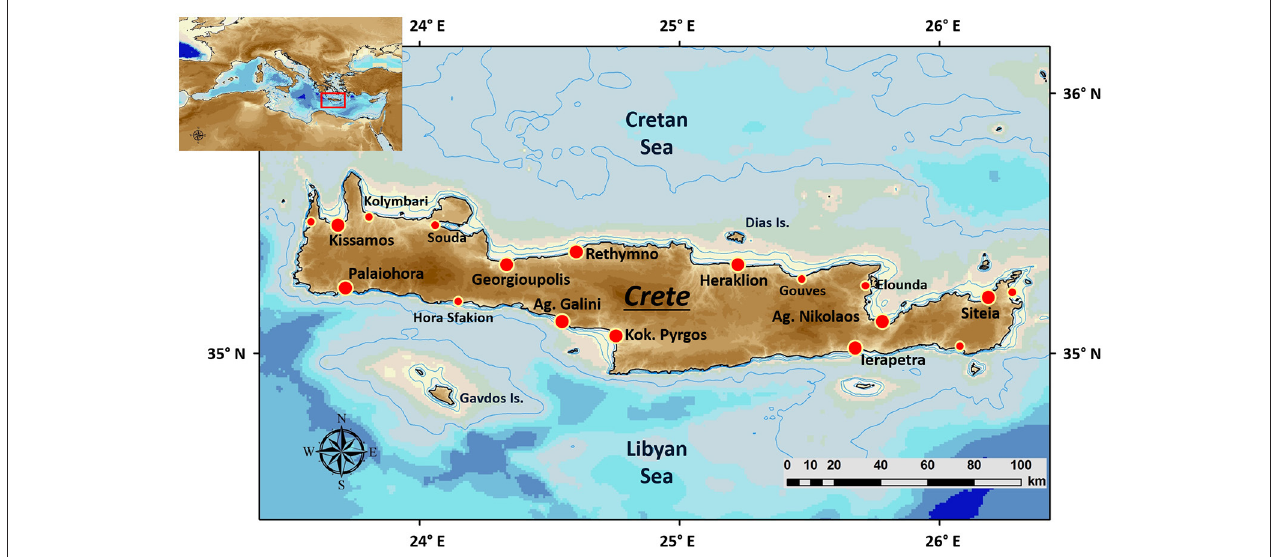
FIGURE 1 | Map of Crete, including main and peripheral ports. Fishing vessels are typically registered at one of the central Coast Guard stations (Heraklion, Chania, Rethymno, Agios Nikolaos). They use one of the main ports as a base for their activities, however they may shift between peripheral ports across seasons so as to maximize yield. We visited each of the 18 ports included in the map at least once over the course of this study ( File S1 ). The map was generated on Arc-GIS software ( ESRI,